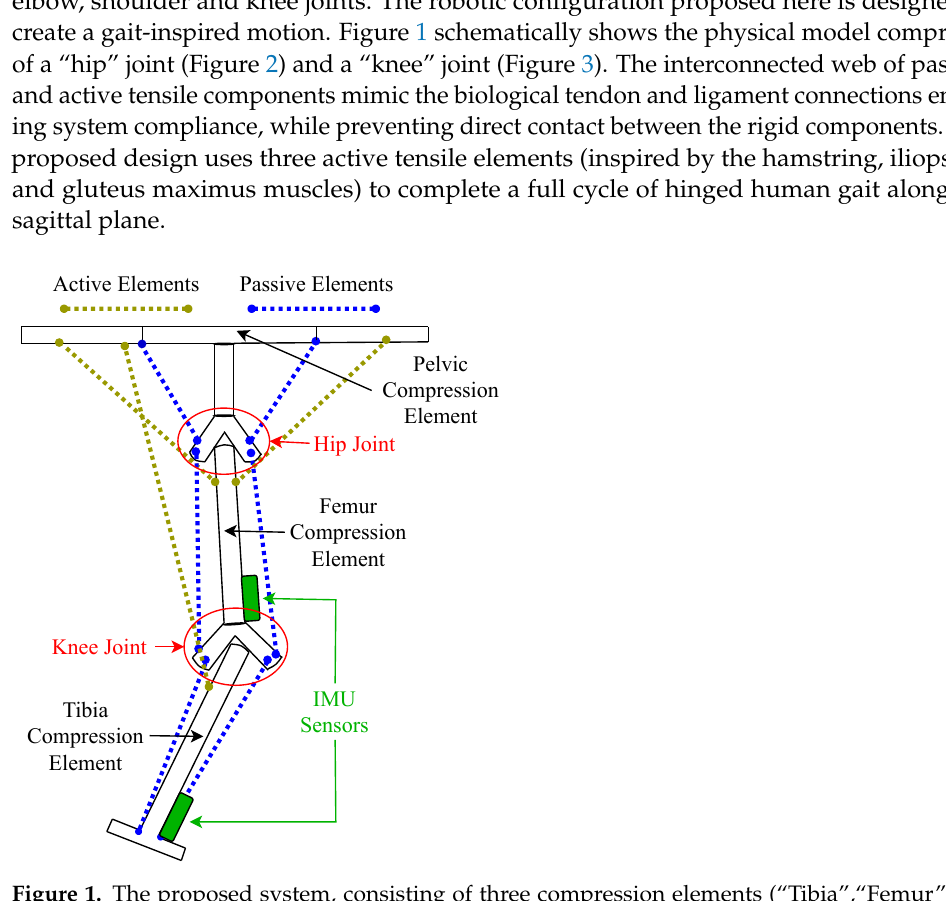
Figure 1. The proposed system, consisting of three compression elements (“Tibia”,“Femur” and “Pelvis”) and two flexural joints (“Knee” and “Hip”) controlled by three active tensile